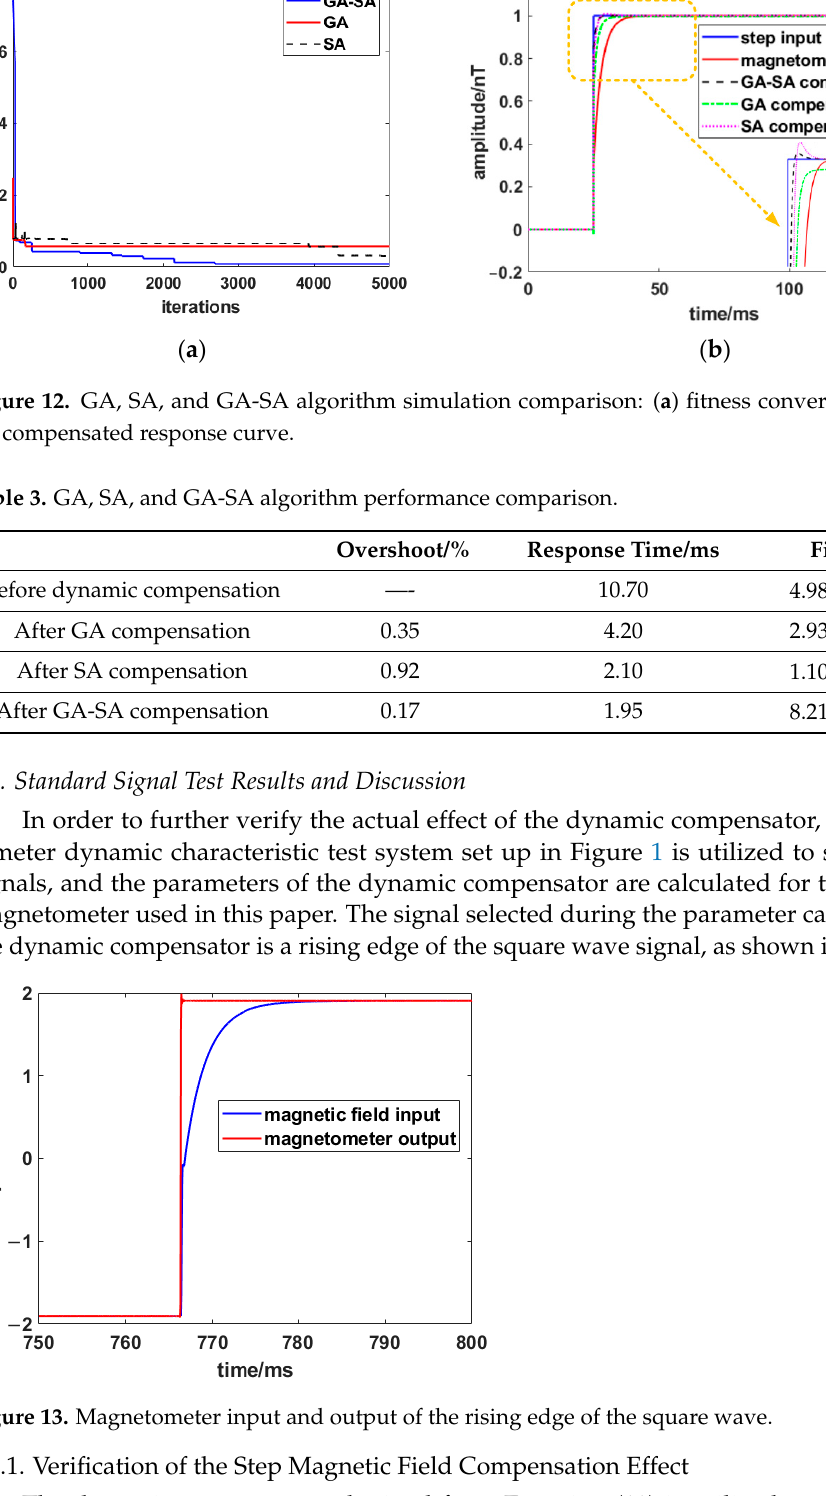
Figure 14. Output of the fluxgate magnetometer after dynamic compensation.